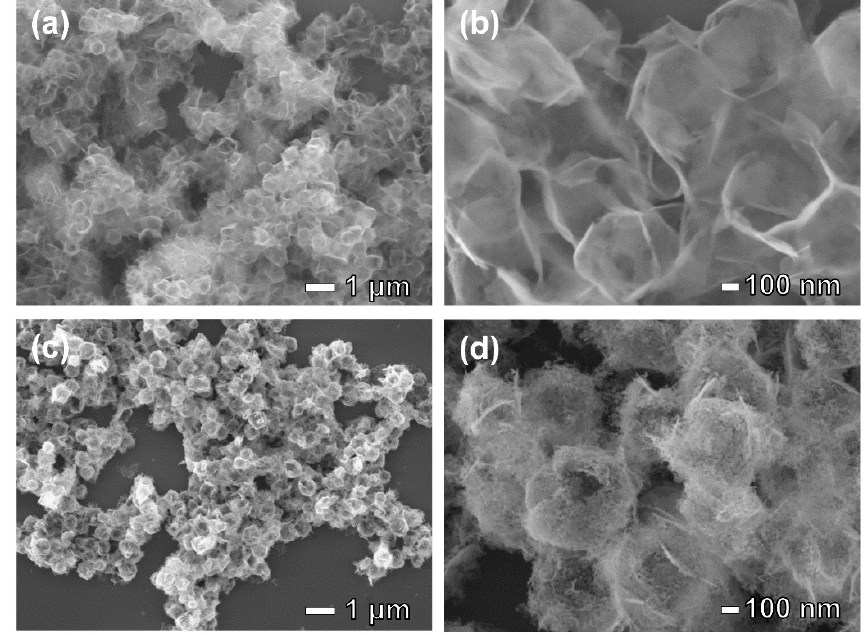
Figure 1. SEM images of ( a ) low- and ( b ) high-magnification of the precursor; ( c ) low- and ( d ) high-magnification of the calcined Co 3 O 4 .